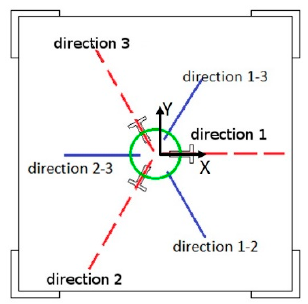
Figure 2. View from above of a module with actuator displacement directions.